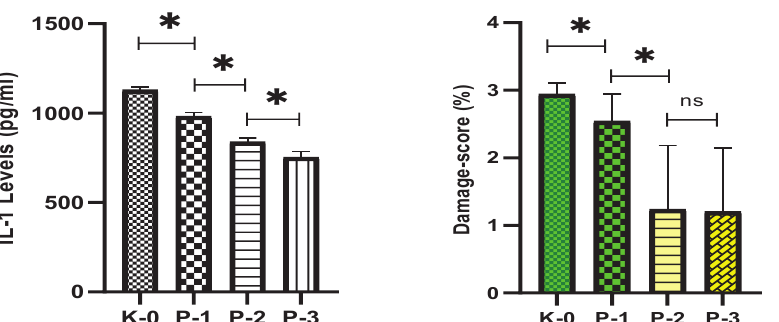
Figure 1. Post Hoc Statistical Analysis on IL-1 Level and Damage Score of Hepatic Cells. * p < 0.05; ns: not significant